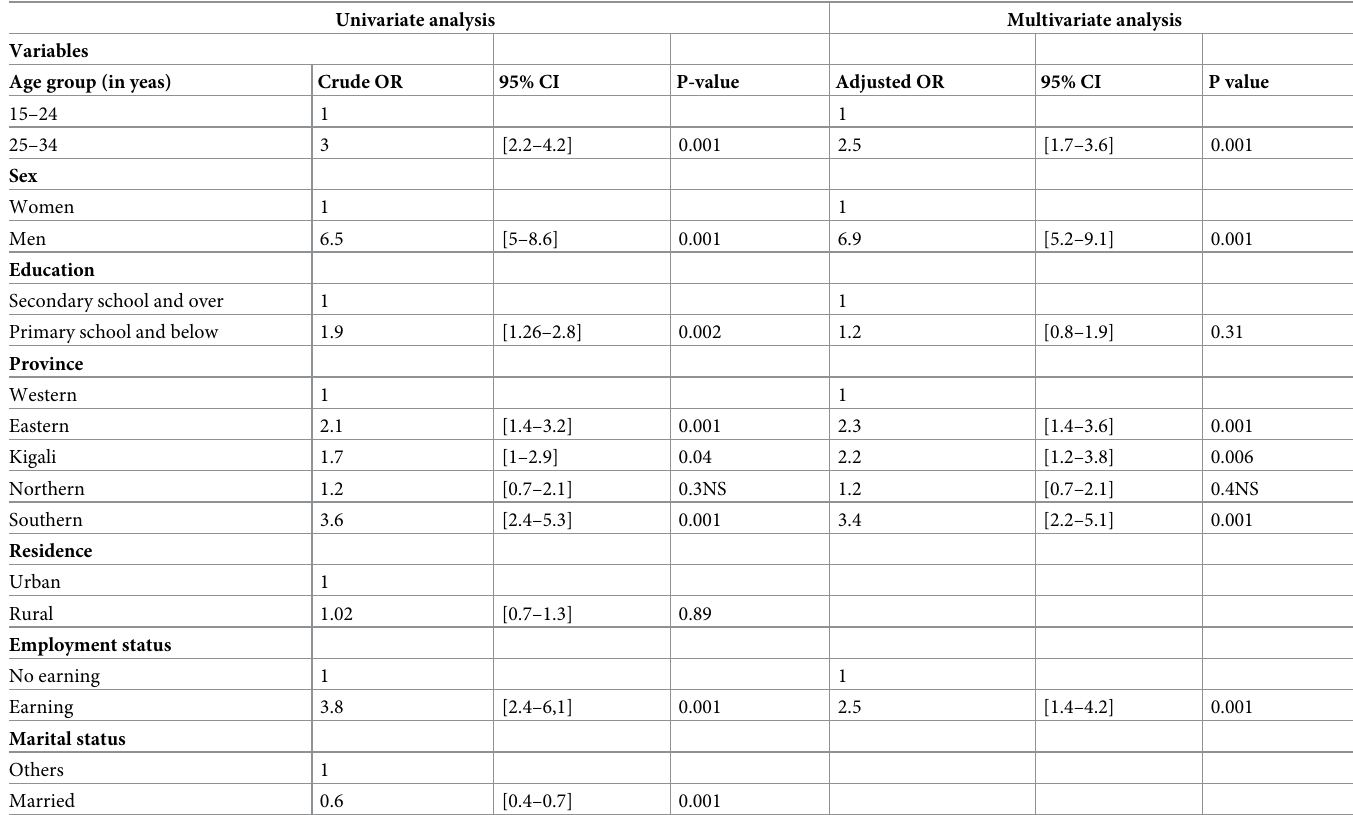
Table 2. Socio-demographic factors associated with tobacco use among Rwandans aged 15–34 years,